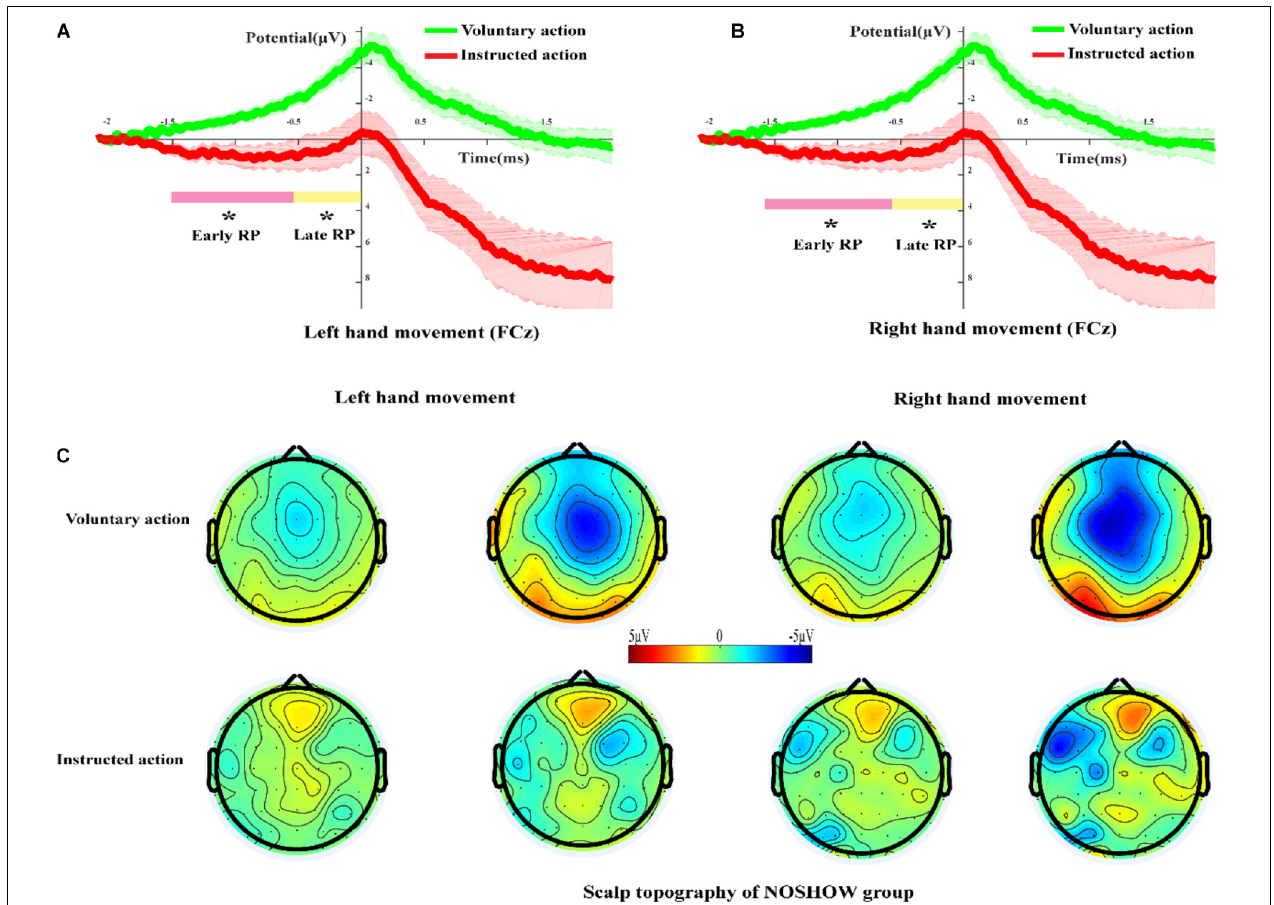
FIGURE 5 | The RP and scalp topography in the NOSHOW group. (A,B) Grand-averaged RP waveform of the voluntary/instructed actions for the NOSHOW group at the FCz site ( A , left-hand movement; B , right-hand movement). (C) Scalp topography of the early and late RPs for voluntary/instructed actions in the NOSHOW group (* p <